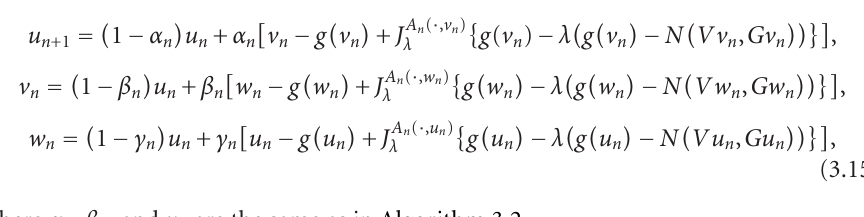
Algorithm 3.5. For any given u 0 ∈ H , compute the approximate solution { u n } by the iterative